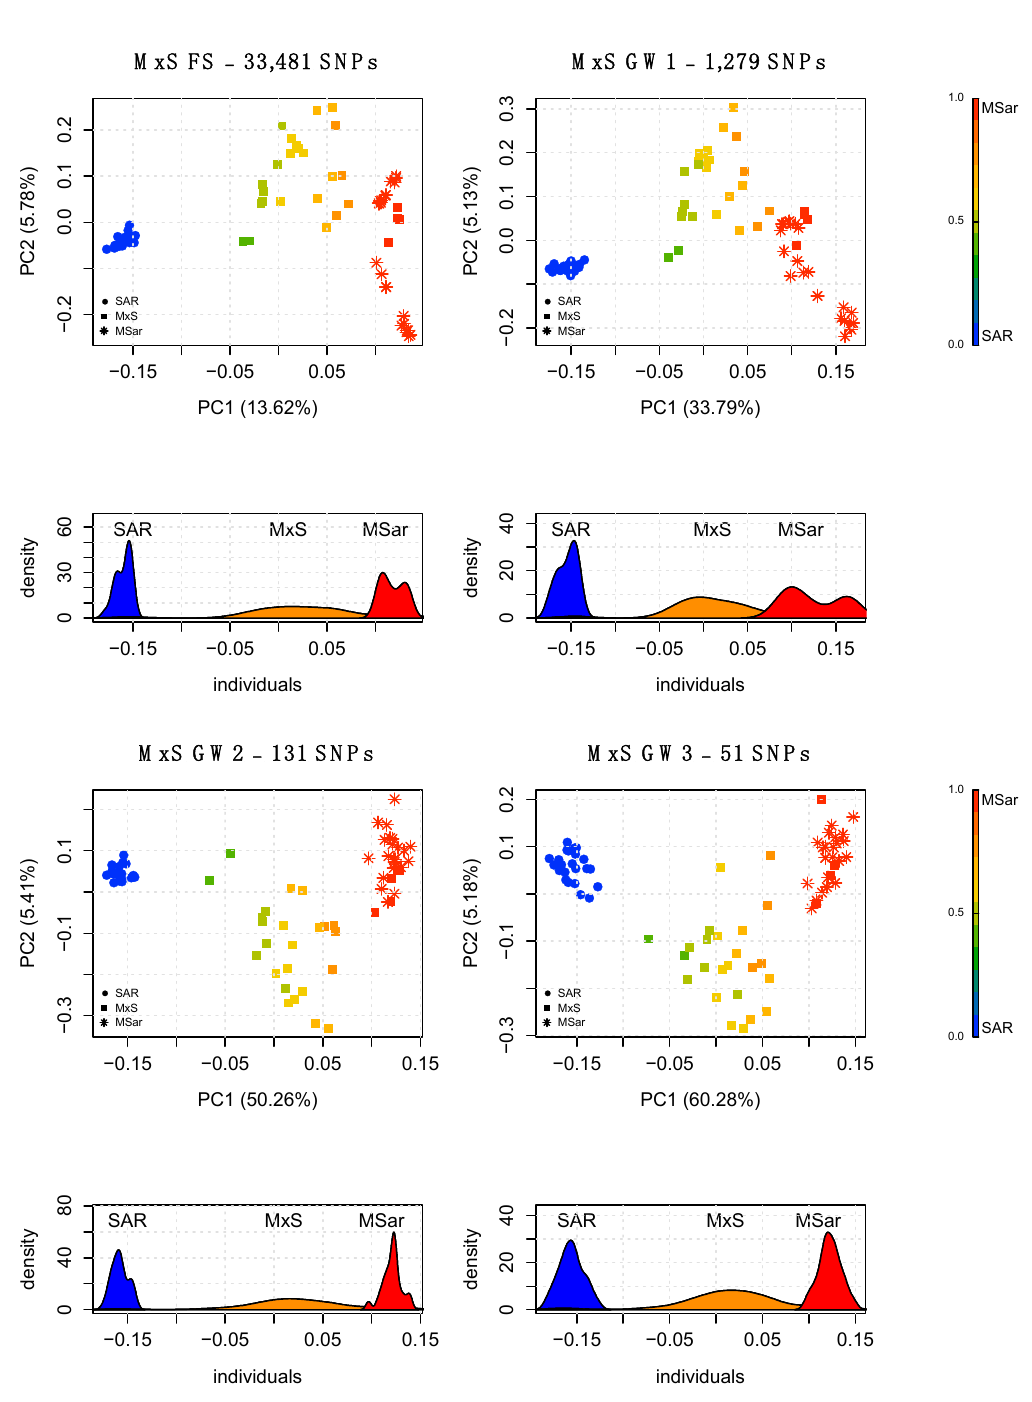
Figure 3. PCA and density distribution of the PC1 obtained using the full SNP set (top-left panel) and three AIMs on reference populations and real mouflon x domestic hybrids (MxS) using the genome-wide discovery approach. The gradient legend on the right side of the plot shows the transition gradient from sheep to mouflon genetic components. The analysis was performed using 33,481 SNPs and the three GW panels.